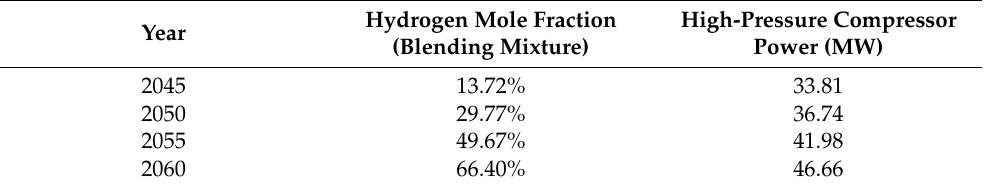
Table 12. LOHC (decalin-naphthalene system) hydrogen processes efficiencies.